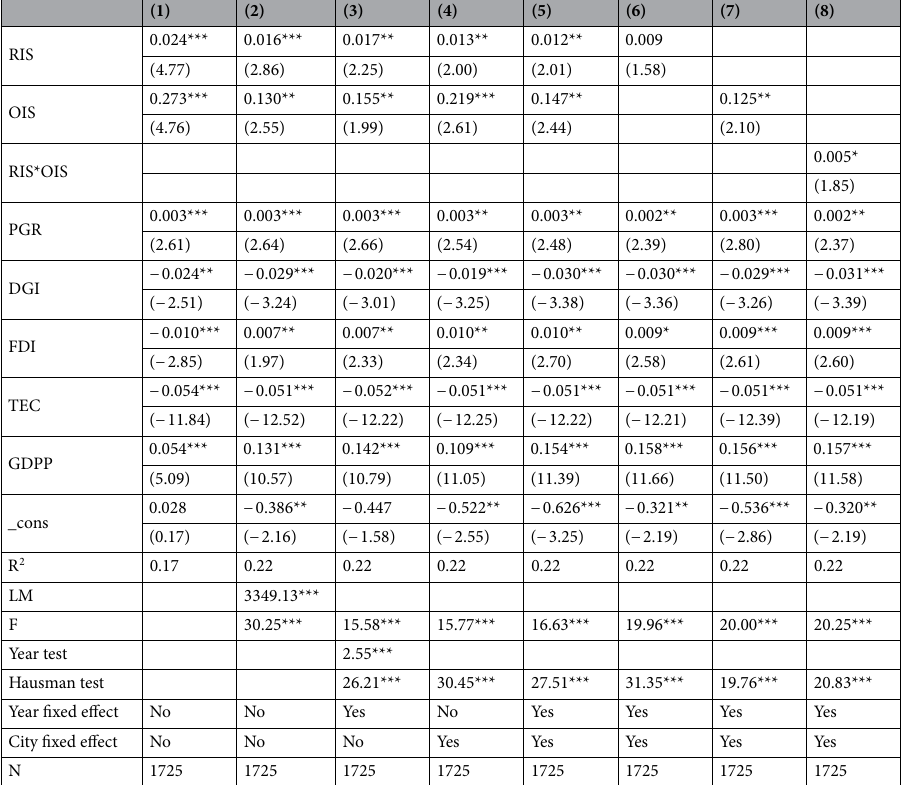
Table 3. Basic regression results. * p < 0.1, ** p < 0.05, *** p < 0.01; the bracket represents the t